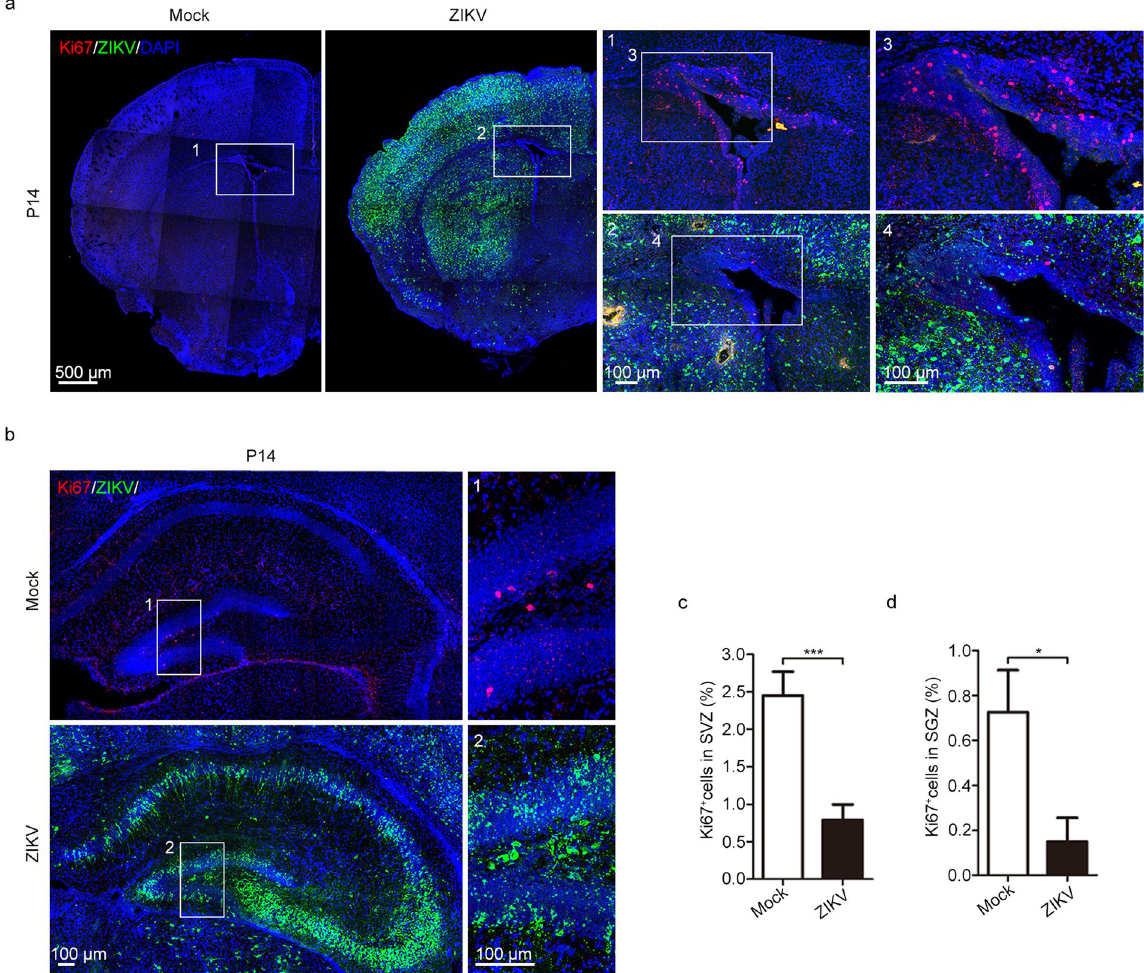
Figure 6. Impaired adult neurogenesis was induced by maternal ZIKV infection. (a) Immunofluorescence staining of Ki67 and ZIKV in the SVZ. (b) Immunofluorescence staining of Ki67 and ZIKV in the SGZ of the hippocampus. (c,d) Percentage of Ki67-positive cells in the SVZ (c) and SGZ (d), respectively. n Mock = 9, n ZIKV = 8 samples from three independent experiments. Data are presented as the mean ± SEM. Student’s t -test, * p < 0.05, *** p <